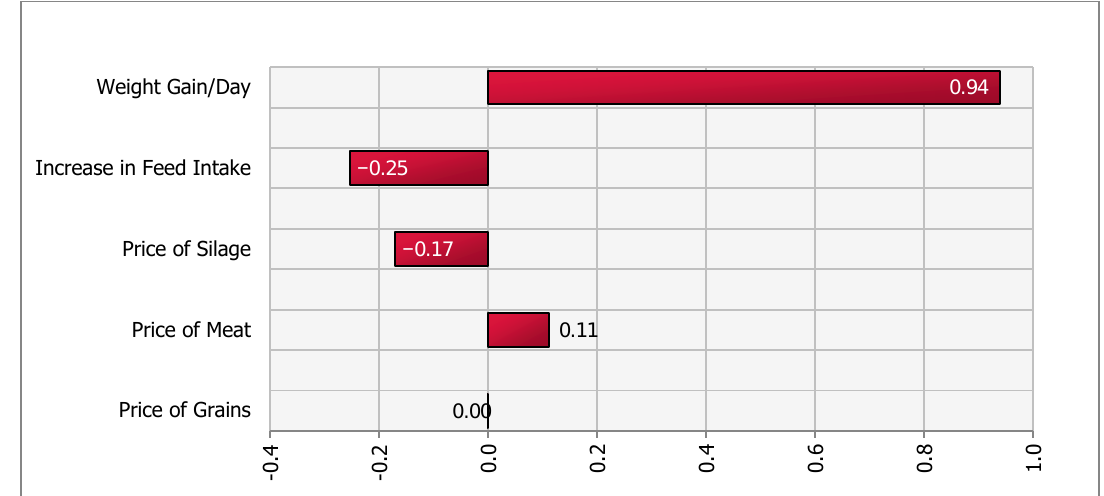
Figure 1. Tornado plot of regression coefficients for determinants of a change in net income under increased space allowance (from 2.2 to 2.7 m 2 /calf)—Scenario 1a.